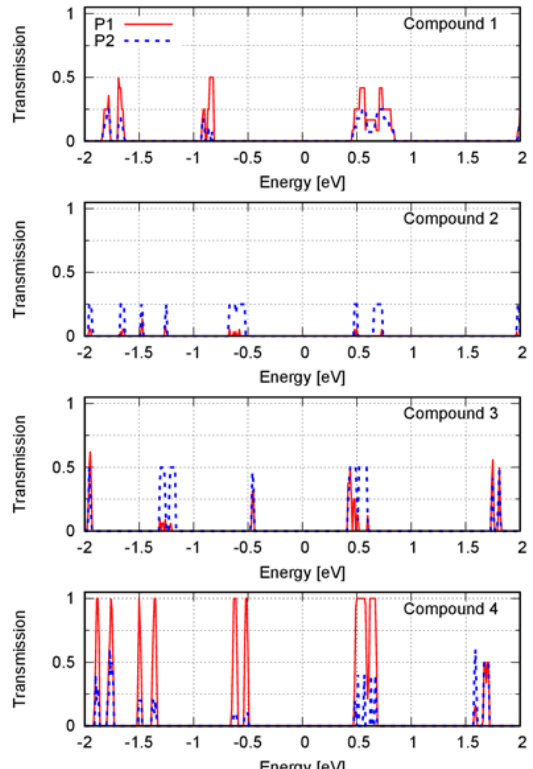
Figure 2. Electronic transmission spectrum along the transport directions P1 (solid red line) and P2 (dashed blue line) for compounds 1 through 4 . The energy was relative to the Fermi level, which was set to zero.